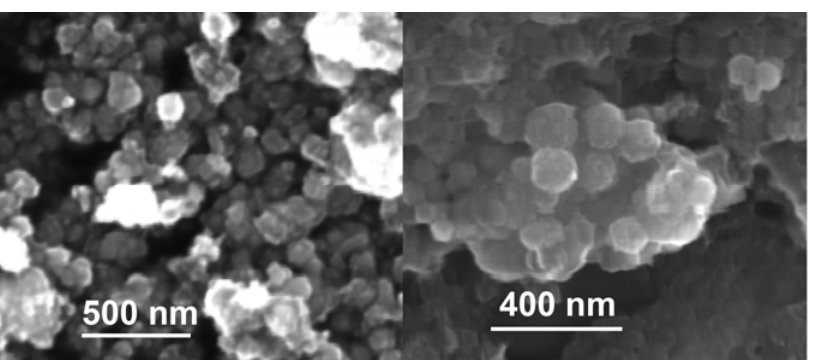
O (left) and Gd III /SiO 2 3